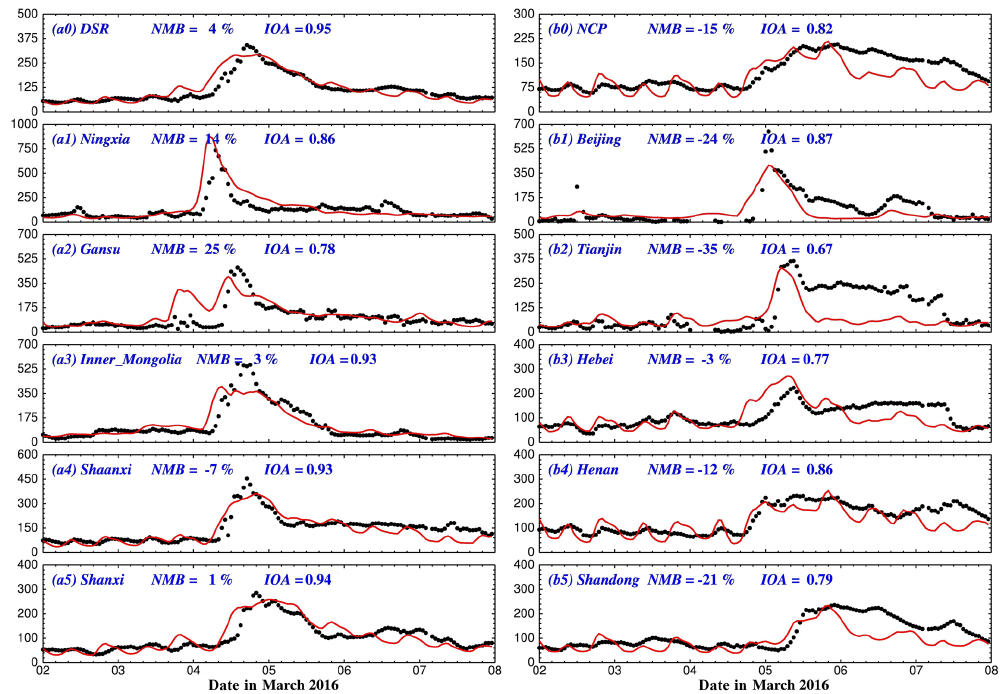
Figure 3. The temporal variations of predicted (red lines) and observed (black dots) diurnal profiles of near-surface [PMC] (µgm − 3 ) over all ambient monitoring stations in provinces within the DSR and the NCP. The locations of measurement sites and provinces can be seen in Fig. 1b. The model performance statistics of the normalized mean bias (NMB) and the index of agreement (IOA) are also shown. The x axis shows the date in March 2016 in Beijing